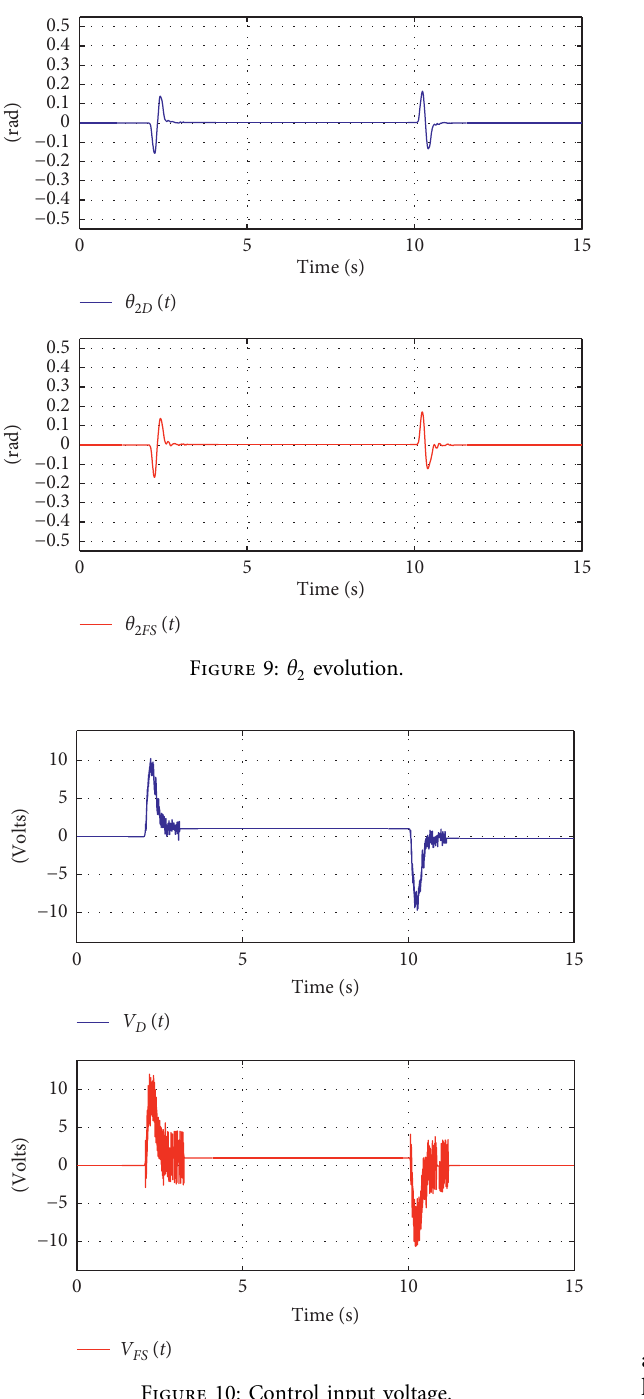
Figure 10: Control input voltage.